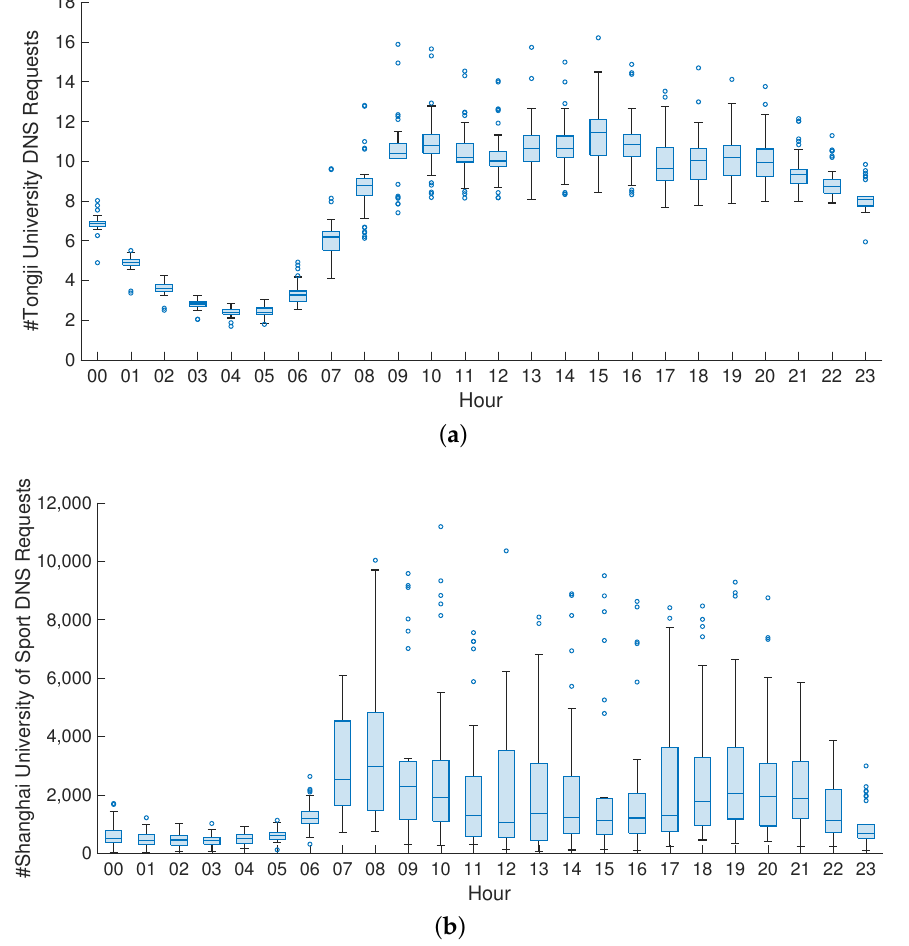
Figure 1. ( a ) Twenty-four-hour DNS requests of Tongji University. ( b ) Twenty-four-hour DNS requests of Shanghai University of